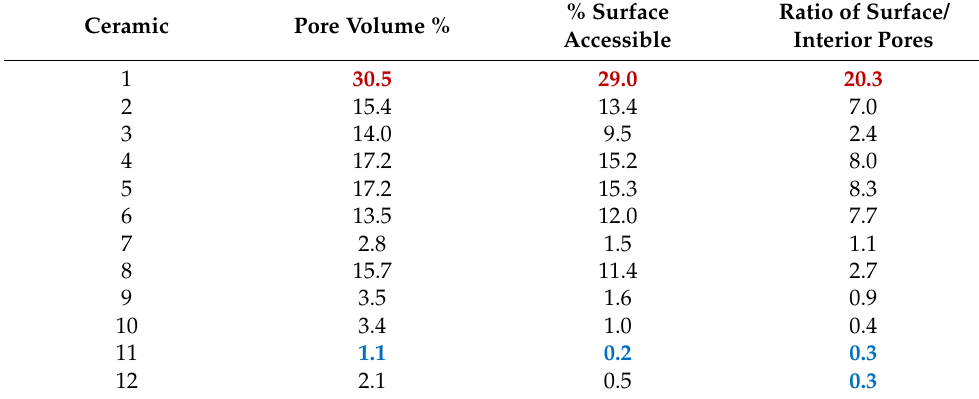
Table 2. Mean volume percent pores, mean percentage surface accessible, and the ratio of pores accessible to a surface versus interior-only